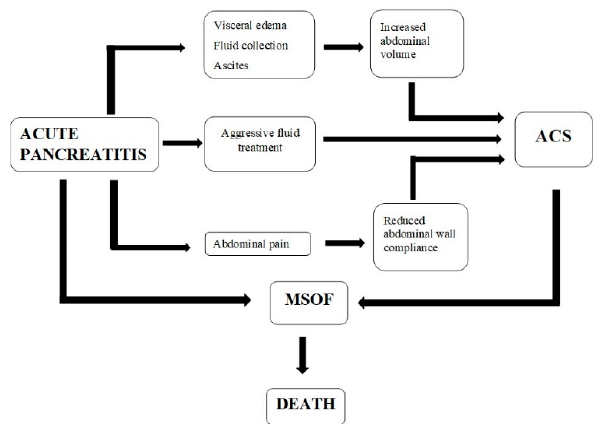
Figure 1. Pathophysiology of abdominal compartment syndrome in acute pancreatitis. ACS—abdominal compartment syndrome; MSOF—multiple system organ failure.